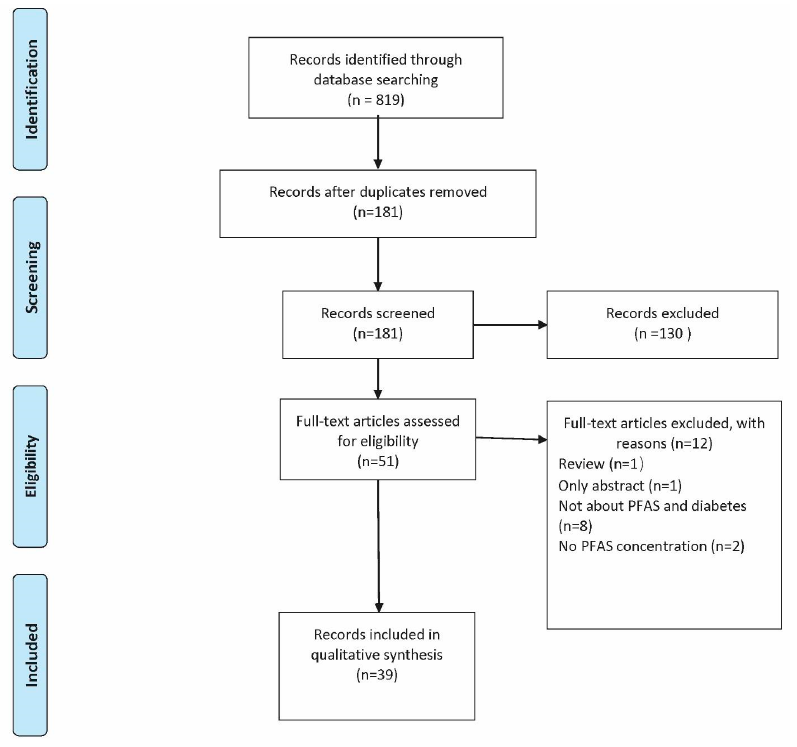
Figure 1. PRISMA flow chart showing search history. PRISMA chart was generated following prescribed systematic and scoping review guidelines (www.prisma-statement.org; accessed on 1 June 2021)